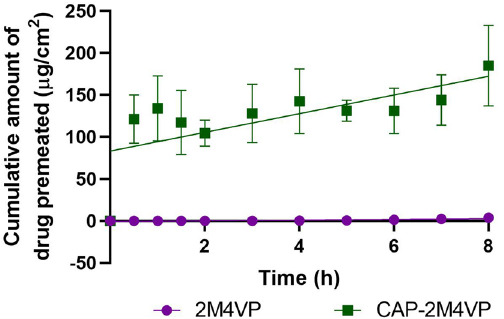
Figure 6. Ex-vivo permeation for the aqueous dispersion of pure drug 2-methoxy-4-vinylphenol (2M4VP) represented in purple colour and the cellulose acetate phthalate nano-formulation of 2M4VP (CAP-2M4VP) represented in green colour across the intestinal mucosal membrane using phosphate buffer pH 7. The figure shows tenfold increase in the cumulative amount of permeation of drug from the CAP-2M4VP nanoparticles compared to the pure sample of 2M4VP.